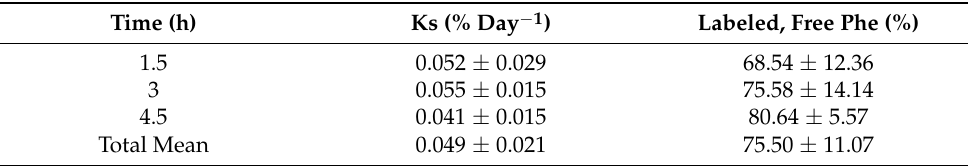
Table 1. Time-dependent protein synthesis rates Ks and percentage of labeled phenylalanine in the free pool in white muscle tissue of Pachycara brachycephalum kept at 0 °C.